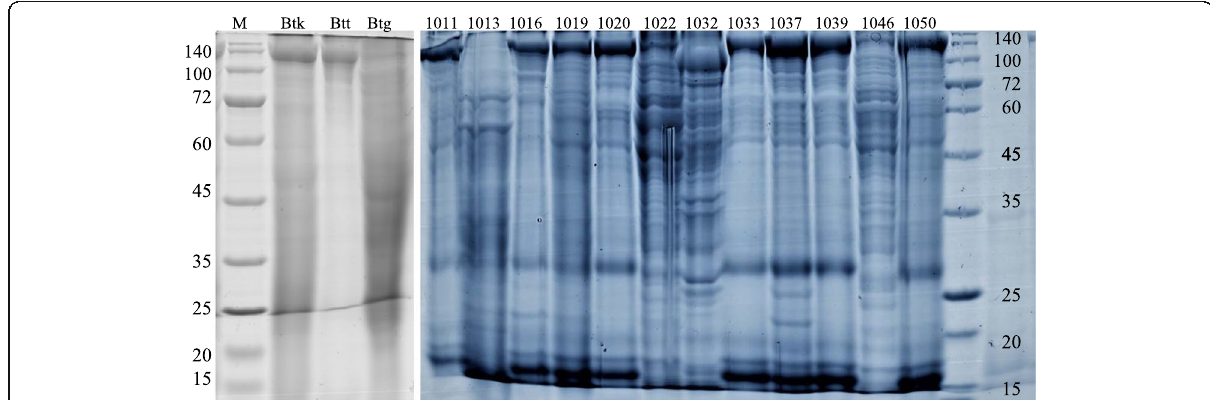
Fig. 5 SDS – PAGE of spore – crystal mixture from Iranian Bacillus thuringiensis strains; M , marker. Reference strains: Bt kurstaki , Bt thuringiensis , and Bt